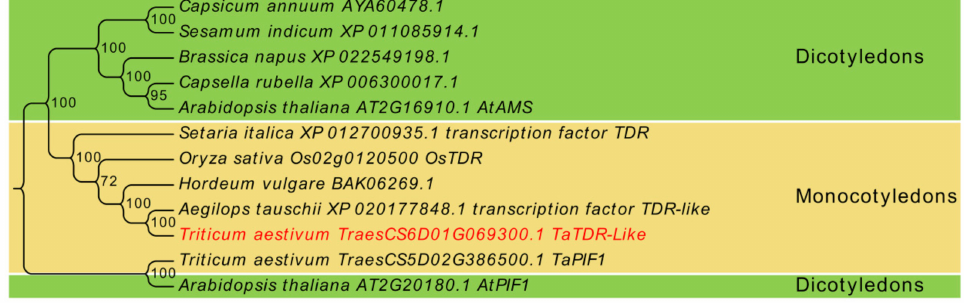
Figure 3. Phylogenetic analysis of TaTDRL. Phylogenetic tree analysis of TaTDRL using Neighbor-joining method using MEGA-X program. Bootstrap values from 1000 replicates were indicated at each